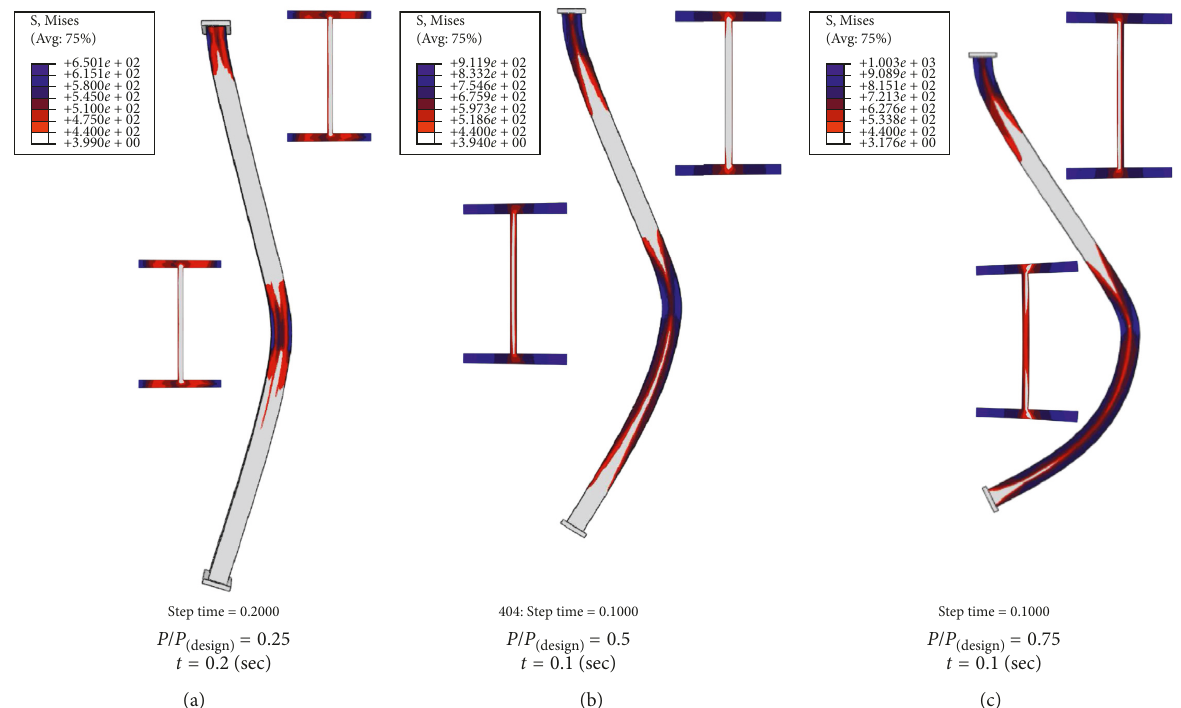
Figure 22: Deformation shape and plastic hinge locations of propped cantilever column W150